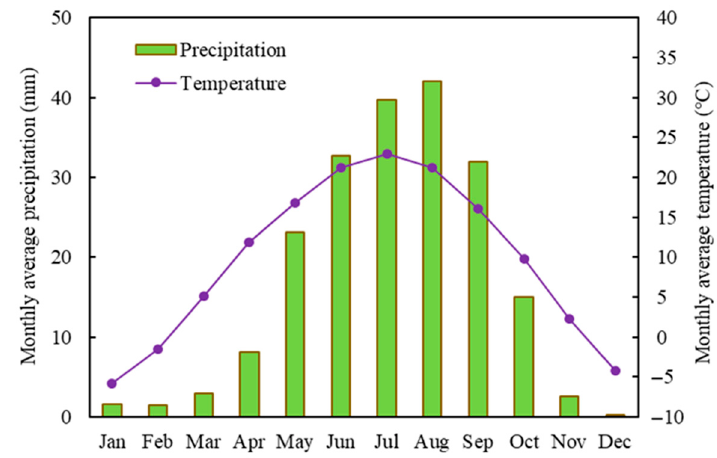
Figure 3. Monthly means of temperature and precipitation.